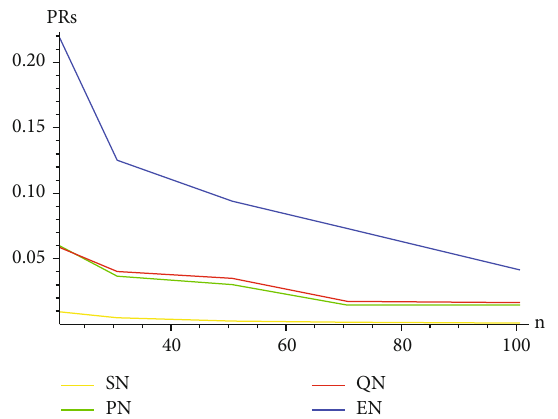
Figure 4: Graph of PRs under di ff erent LFs using NIP for λ = 0 : 1 , using γ = 0 : 5 .